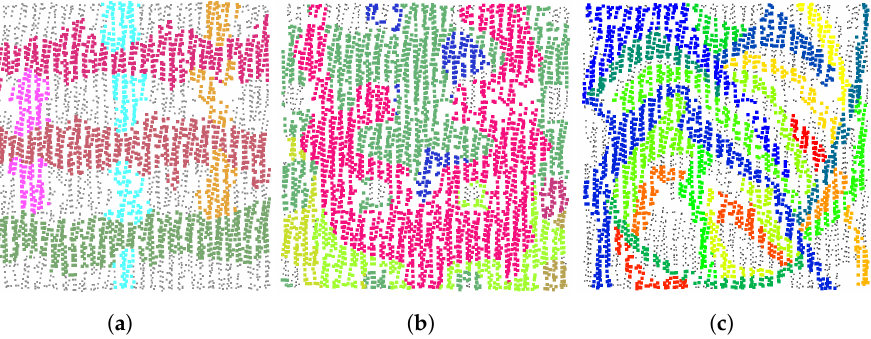
Figure 9. A local comparison of the our direct results with those of efficient RANSAC. ( a ) Our results before post-segmentation, ( b ) efficient RANSAC for all shapes, and ( c ) efficient RANSAC for cylinders